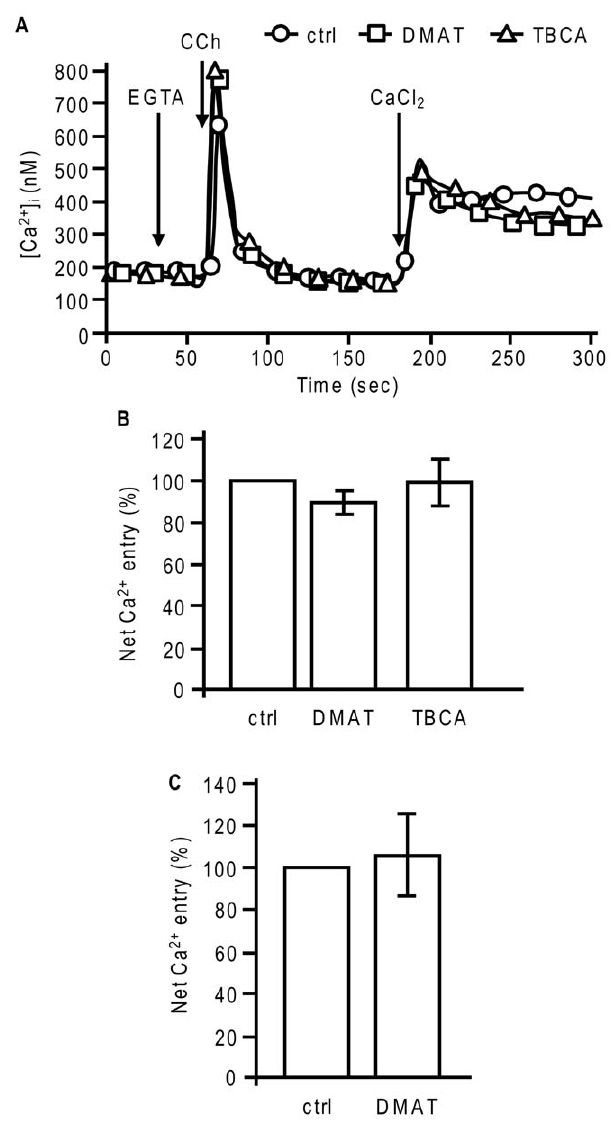
Figure 6. The inhibition of CK2 with specific inhibitors does not alter TRPC6 activity. A , Fura-2-loaded T6.11 cells were left untreated (circles) or were treated for 4 h with 10 m M DMAT (squares) or 10 m M TBCA (triangles). CCh (5 m M) induced Ca 2 + release in the absence of extracellular Ca 2 + while Ca 2 + restoration 2 min later induced Ca 2 + entry. DMAT and TBCA concentrations were maintained during the assay. The graphs are representative of 176 to 227 cells from one typical experiment. B , Net maximal Ca 2 + entries from A were calculated as in Figure 3 and are relative to the control (100%). The histogram represents the average 6 SD of four independent experiments. C , The same protocol was carried out on A7r5 cells using 100 nM AVP instead of CCh. The net maximal Ca 2 + entry was calculated relative to the control (100%). The histogram is the average 6 SD of three independent